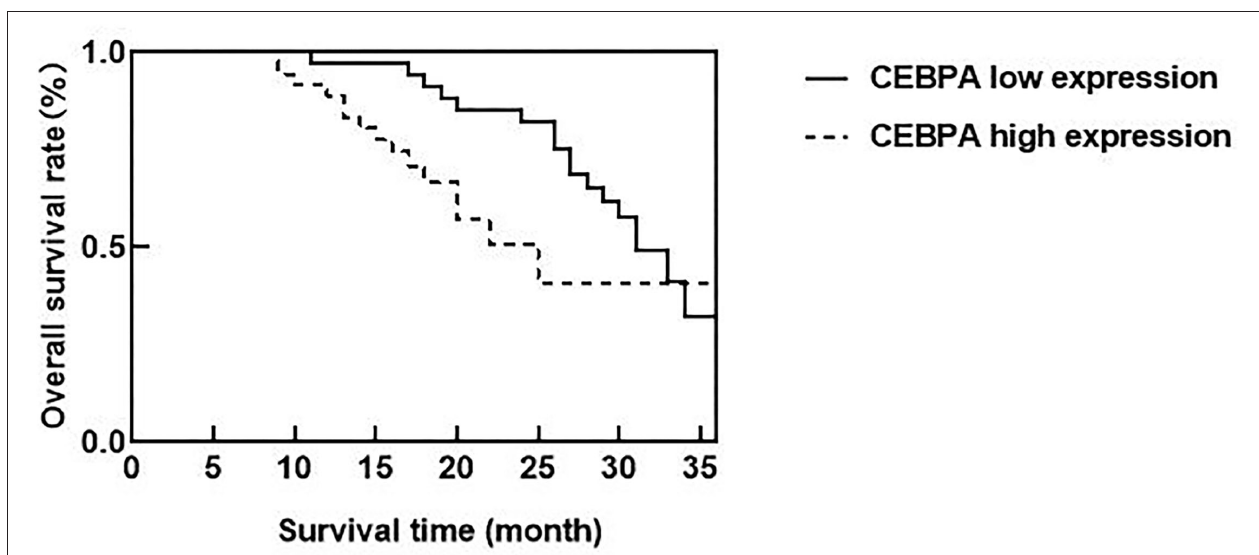
FIGURE 4 | Relationship between CEBPA level and prognosis of patients. CEBPA, CCAAT enhancer-binding protein alpha.